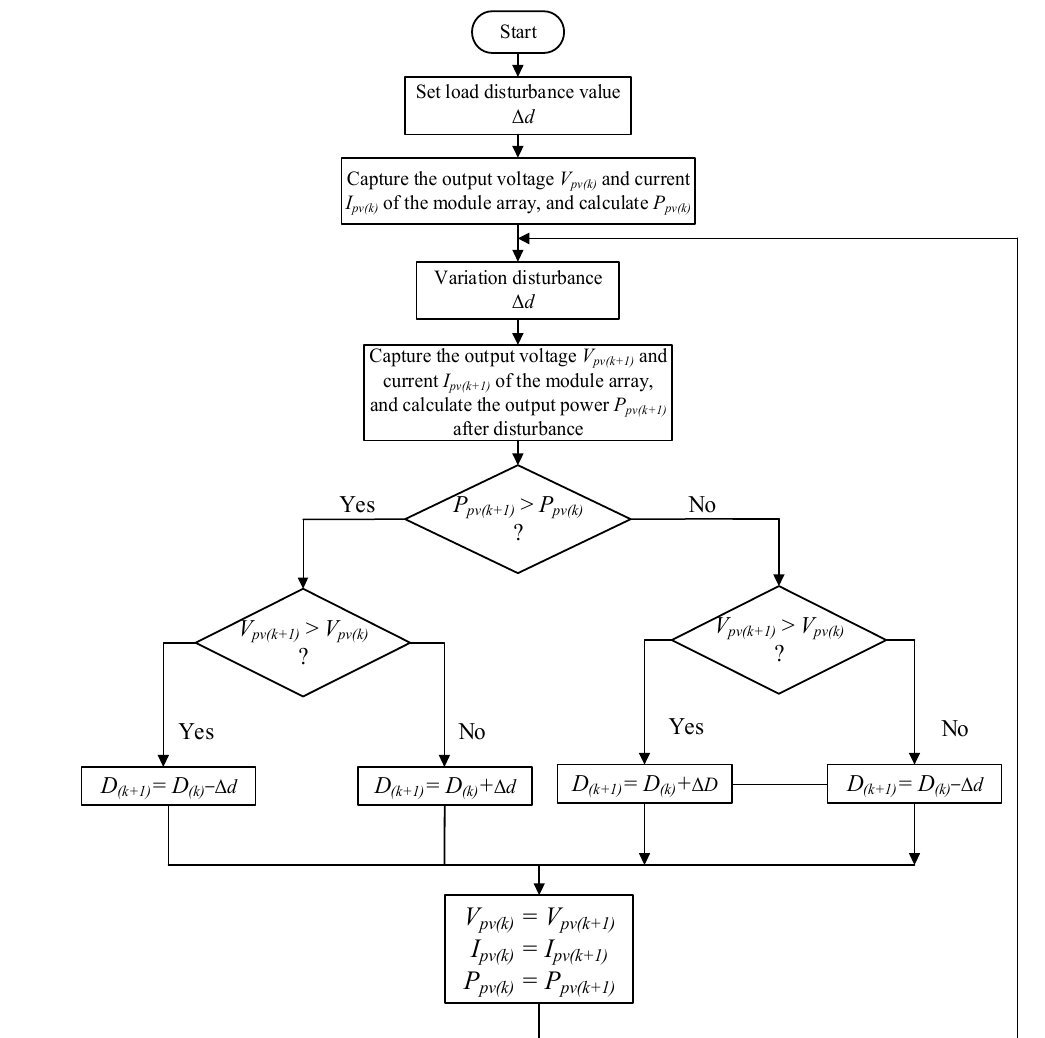
Figure 2. The flow chart of P&O method.